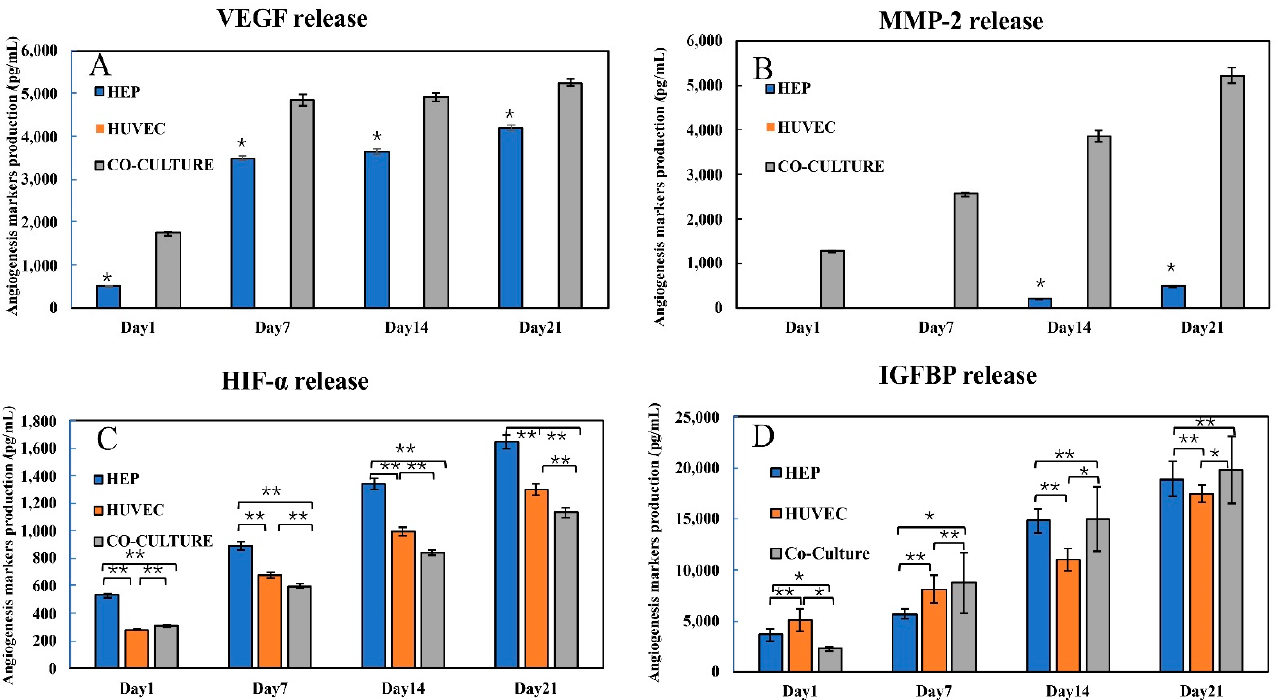
Figure 7. ( A ): VEGF; ( B ): MMP-2; ( C ): HIF1- α ; and ( D ): IGFBP-1. Production of the individual Hep-G2 clusteroids, HUVEC clusteroids, and co-culture clusteroids at a cell ratio of 5:1 (Hep-G2: HUVEC) during 21 days of proliferation in 5 mg mL − 1 Matrigel. The initial total cell number was 1 × 10 6 mL − 1 for all three sets. Data were plotted as mean ± standard deviation of at least three independent experiments. Statistically significant differences between each region are denoted by * ( p < 0.05) or ** ( p < 0.01).